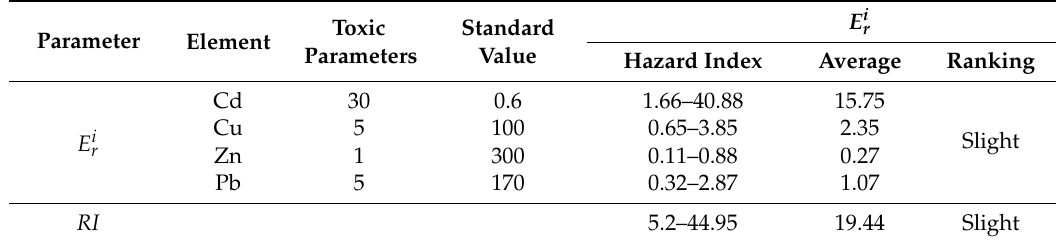
Table 5. The classification of potential ecology hazard by